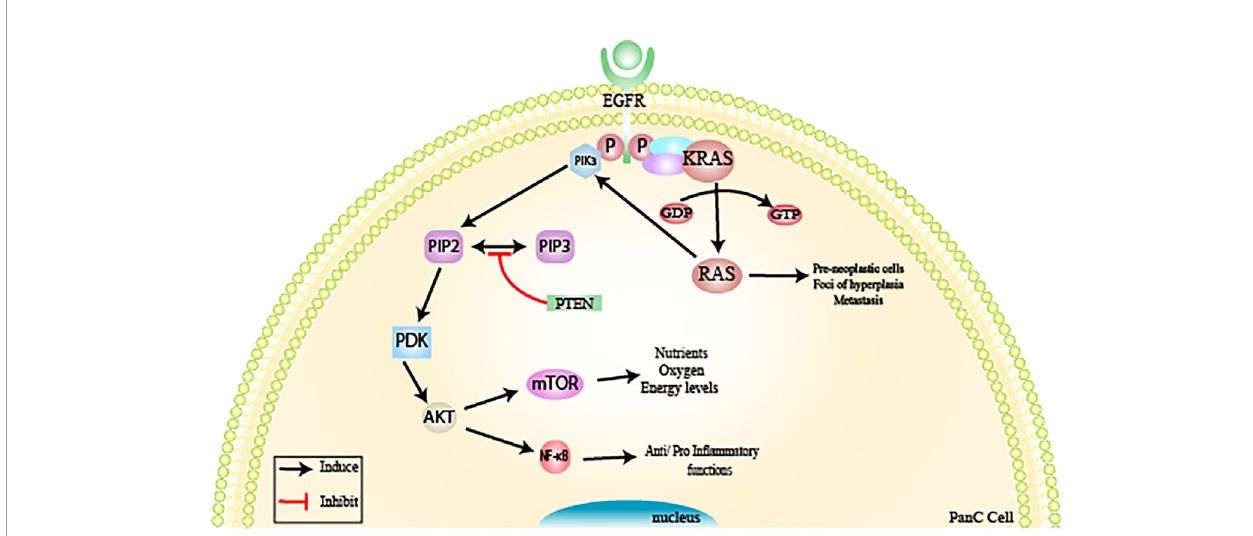
FIGURE 3 | Inactivation of tumor suppressor genes via KRAS/PI3K/PTEN/AKT. The KRAS oncogene is considered the most frequent mutation in the pancreatic tumorigenesis process observed in pancreatic adenocarcinoma (PanIN-1) and is involved in signal transduction of an important cell signaling pathway, the PI3K/ PTEN/AKT pathway. KRAS encodes the Ras protein through a small GTPase-binding protein. Active RAS is promoted by guanine nucleotide exchange factors (GEFs) in response to stimulation of a cell surface receptor, epidermal growth factor receptor (EGFR, a member of the human tyrosine kinase epidermal receptor family), resulting in the recruitment of PI3K. PI3K will form PIP2 (phosphatidylinositol 4,5-bisphosphate) and then PIP3 (phosphatidylinositol 4,5-triphosphate. The second messenger PIP3 recruits AKT (serine/threonine kinase) and PDK1 (phosphoinositide-dependent kinase 1 to the membrane). AKT affects various signaling pathways, such as the mTOR pathway, which regulates nutrient, oxygen, and energy levels in cells and the NF- k B pathway (nuclear factor kappa B). PTEN is responsible for regulating the intensity of PI3K and, consequently, its effects on the intracellular signal transduction cascade. PTEN de fi ciency or absence causes hyperactivity of the PI3K pathway, due to the accumulation of PIP3, leading to the appearance of high degrees of neoplastic transformations. From: